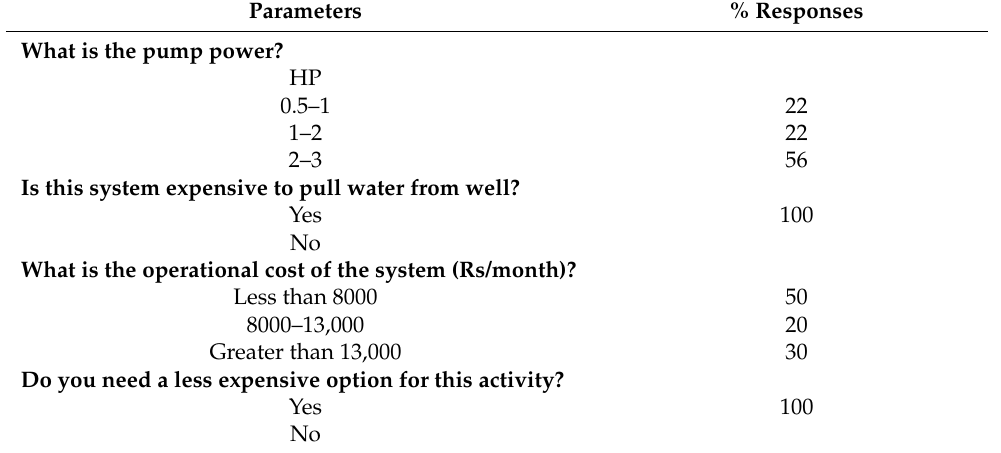
Table 6. Salient features of electric-operated pumps for water pumping from dug wells.